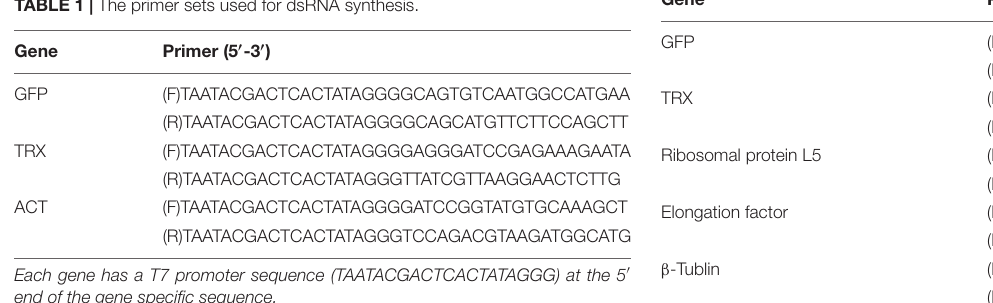
TABLE 2 | Forward (F) and reverse (R) primer sets used in the quantitative real-time PCR.